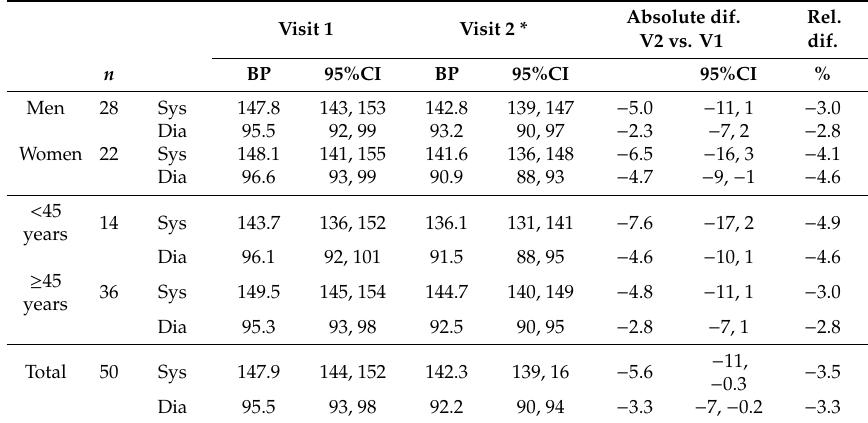
Table 4. Prevalence of hypertension in the community-based screening programme based on blood pressure measured on two vs. one visits.